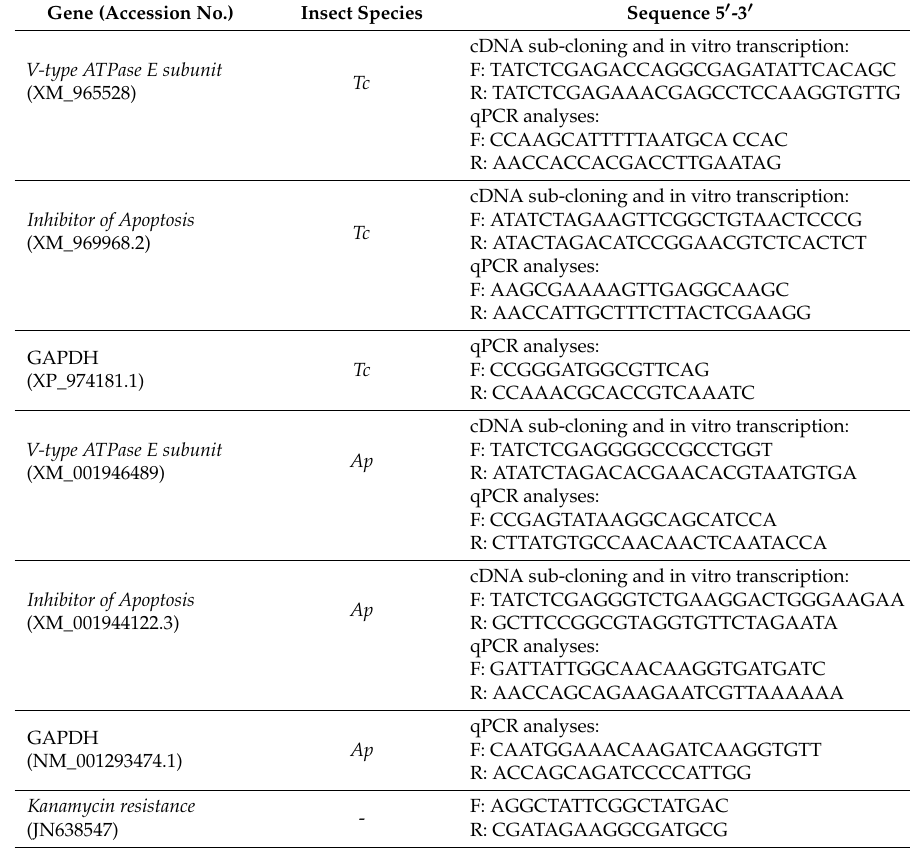
Table 1. Sequence of forward (F)/reverse (R) primers used for cDNA sub-cloning, dsRNA synthesis and qPCR analysis. Tc denotes T. castaneum and Ap denotes A. pisum